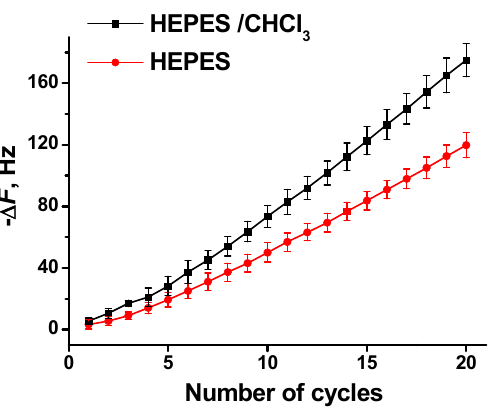
Figure 6. Dependence of the EQCM frequency shift on the number of potential cycles during poly(Azure B) electropolymerization in different conditions. Results represent mean ± S.D. obtained from 6 independent experiments.